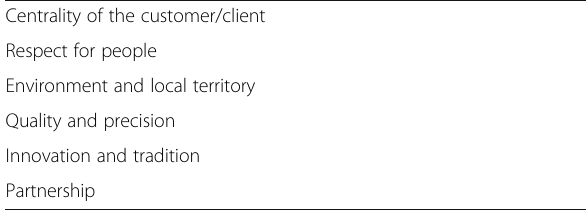
Table 2 Paradisi ’ s founding values Centrality of the customer/client Respect for people Environment and local territory Quality and precision Innovation and tradition